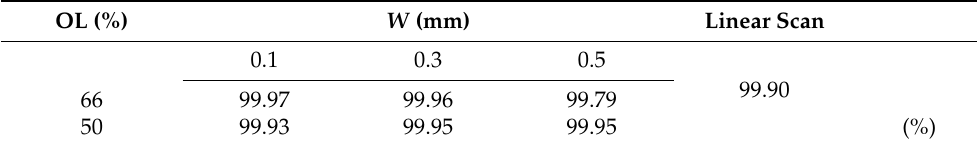
Table 2. Density analysis of test